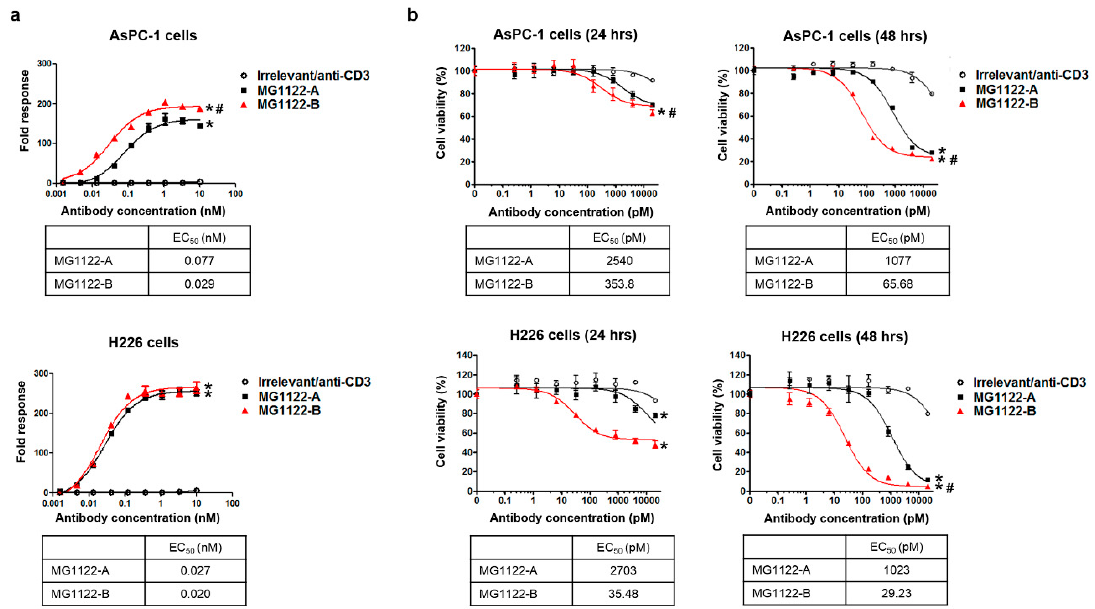
Figure 3. T-cell activation and cytotoxic activity of bispecific antibodies against cancer cell lines. ( a ) Bispecific antibody-mediated, T-cell activation was measured by incubating Jurkat-NFAT-luc cells with AsPC-1 or H226 cancer cells in the absence or presence of increasing concentrations of bispecific antibodies. RLU, relative luminescence units corresponding to the intensity of luciferase expression downstream of CD3. ( b ) Dose-dependent tumor cell lysis was detected at 24 and 48 h after incubation of bispecific antibodies with human peripheral blood mononuclear cells and tumor cells (effector:target ratio, 10:1). * p < 0.01 vs. irrelevant/anti-CD3, # p < 0.01 vs. MG1122-A.